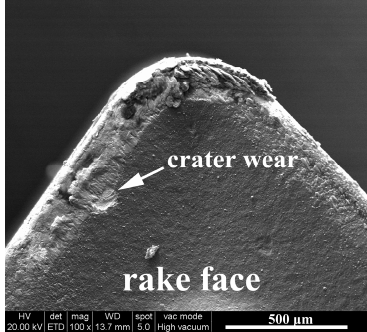
Figure 10. SEM image of rake face of the TiAlN-coated insert after machining for 12 min (cutting speed of 50 m/min, feed rate of 0.1 mm/r, depth of cut of 1.0 mm).